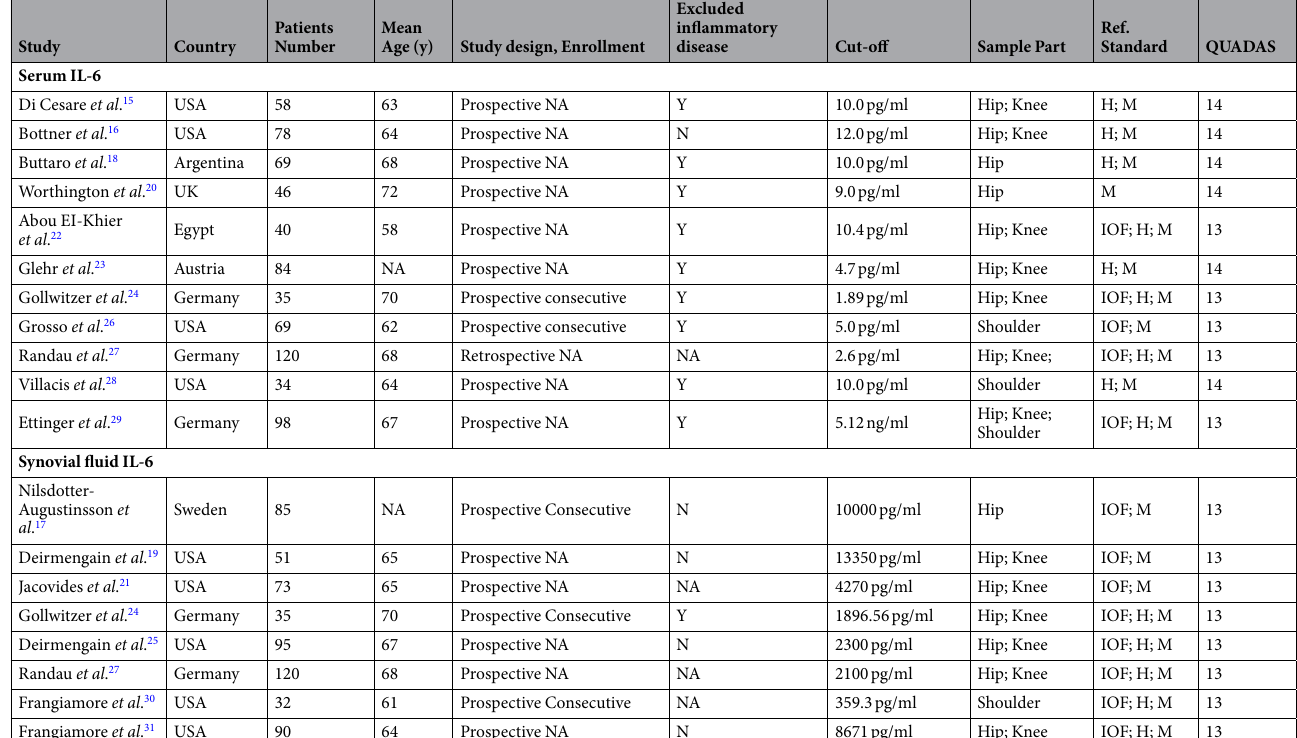
Table 1. Characteristics of the studies in meta-analysis for the diagnosis of PJI using serum and synovial